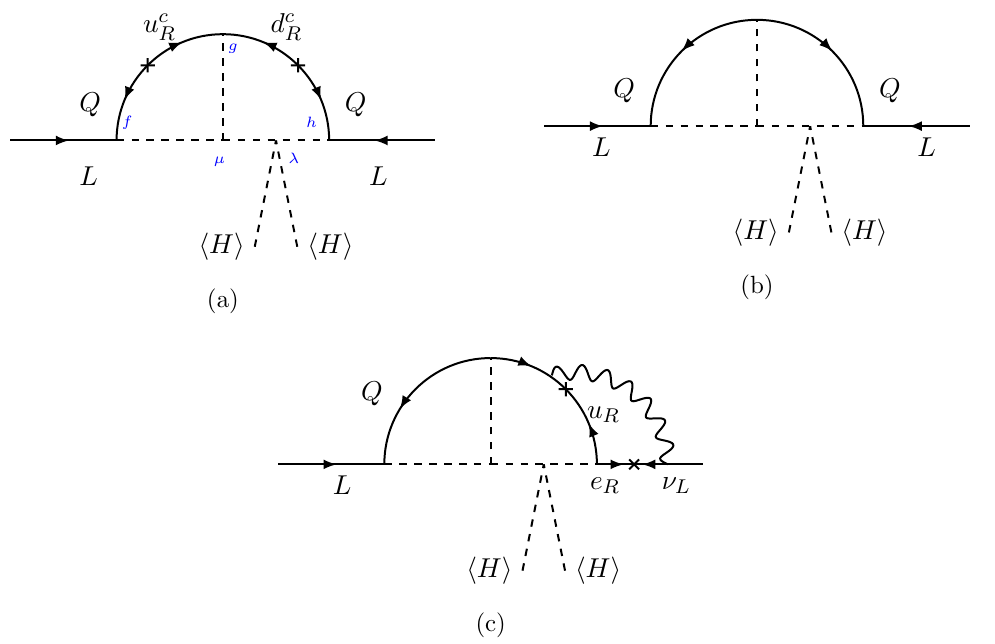
Figure 2 . Generic neutrino mass diagrams from the completions of operators (a) O 25 , (b) O 47 and (c) O 55